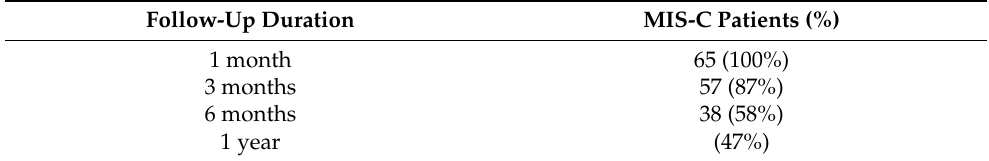
Table 1. MISC patients with cardiac involvement in follow-up. Follow-Up Duration